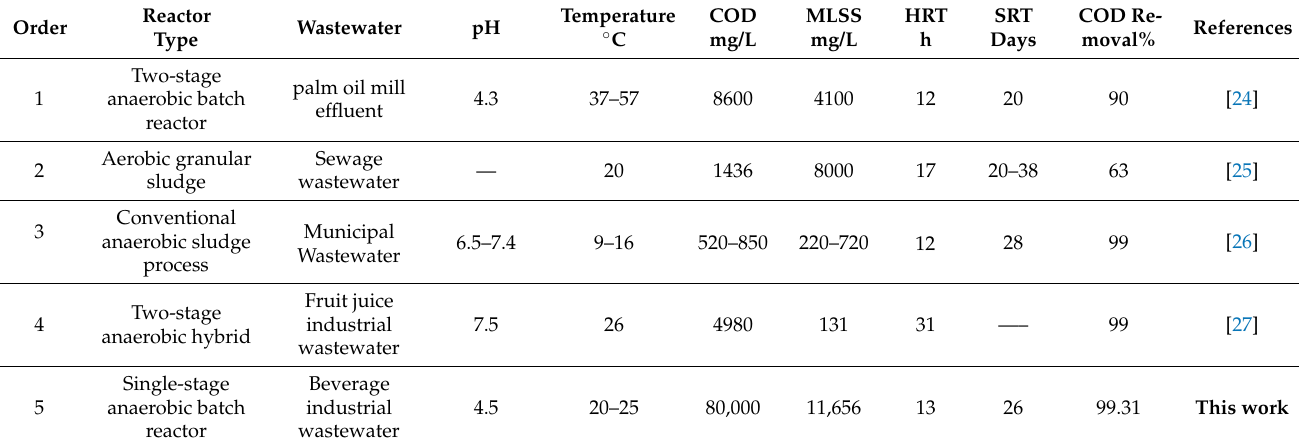
Table 7. Comparison of the initial characteristics of wastewater results with reported literature.